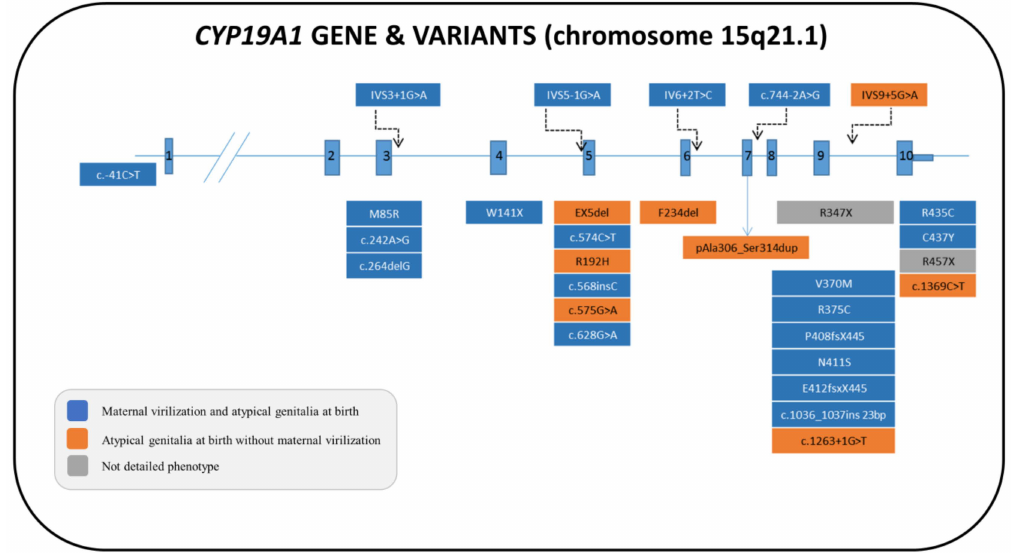
Figure 6. Structure of the human CYP19A1 gene with the pathogenic variants that have been described in 46,XX patients. The nomenclature and the color of the boxes of each pathogenic variant are in accordance with the phenotypic characteristics described in each patient, the variant present on the second allele and the references cited in Table